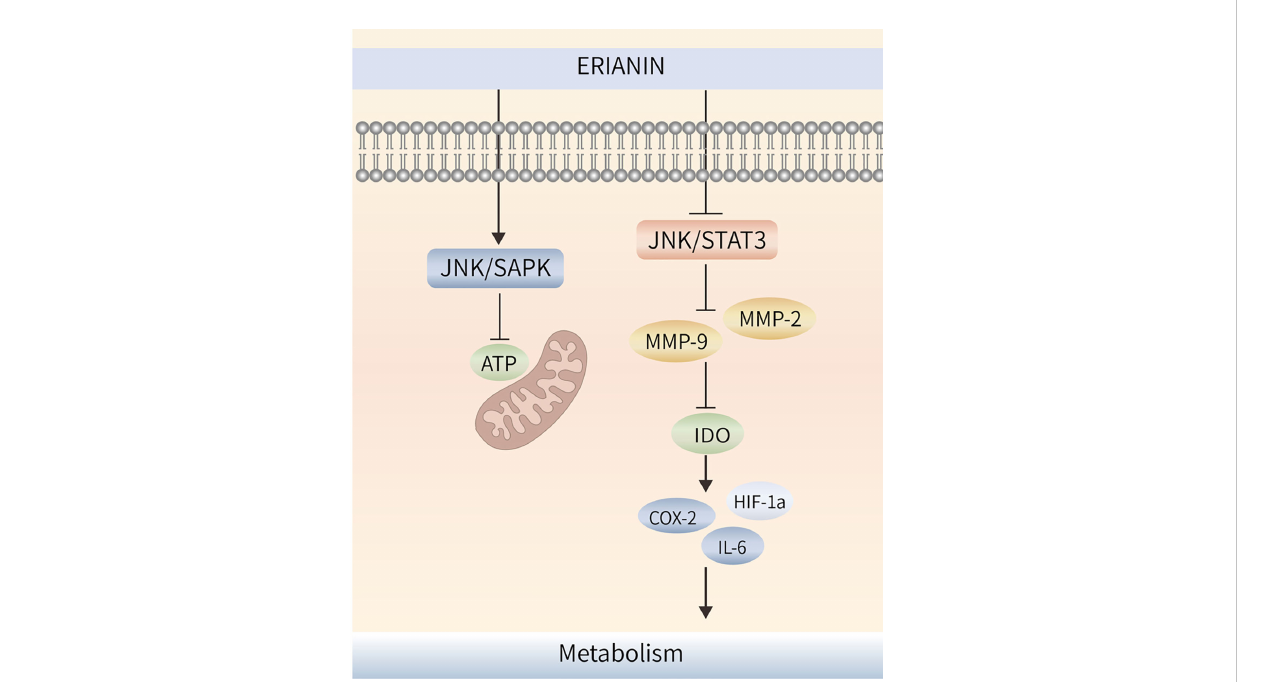
FIGURE 4 ERIANIN regulates cell metabolism through the JNK/SAPK/STAT3 pathway. ERIANIN induces activation of the JNK/SAPK pathway, downregulates the rate of extracellular acidi fi cation, reduces lactate production and glucose consumption, decreases cell survival, and reduces intracellular ATP content. In addition, ERIANIN can regulate the JAK/STAT3 pathway, inhibit the expression of p-JAK and p-STAT3, downregulate MMP-9 and MMP-2, reduce IDO activity, decrease the expression of IDO-mediated in fl ammatory mediators, including COX-2, HIF-1 a , and IL-6. ATP, adenosine triphosphate; SAPK, mitogen-activated protein kinase 9; IDO, indoleamine 2,3-dioxygenase; COX-2, cytochrome c oxidase subunit II; IL-6, interleukin 6; HIF-1 a , hypoxia inducible factor 1 subunit